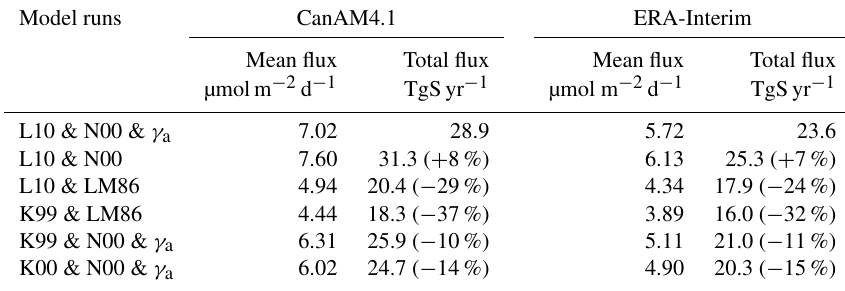
Table 2. Ocean emissions of DMS from CanAM4.1 and offline calculations with reanalysis fields. DMS flux is derived for the time period of the model simulations (January 2004 to December 2008). Quantities in parentheses are percentage changes relative to the reference run (L10 & N00 & γ a ).